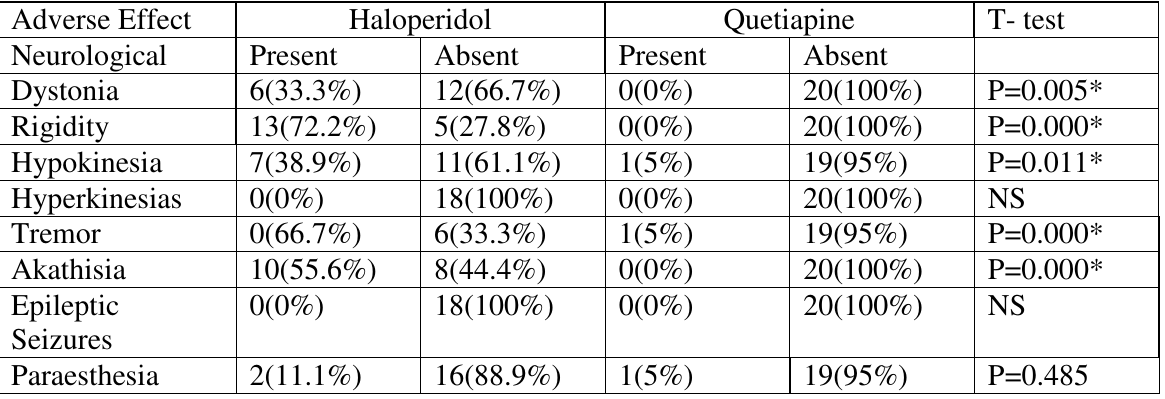
Table II: neurological side-effects observed in both the groups during the study Adverse Effect